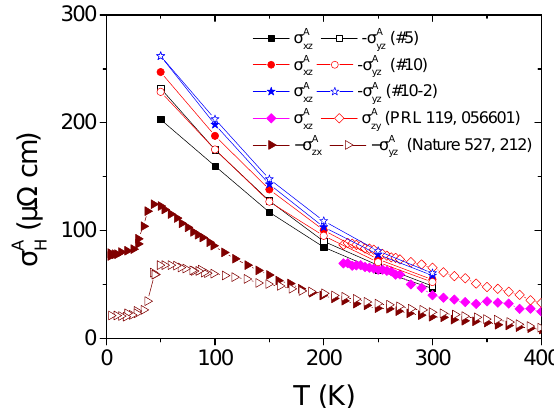
Figure S6: a) The temperature dependence of anomalous Hall conductivity in differ- ent samples and in previous